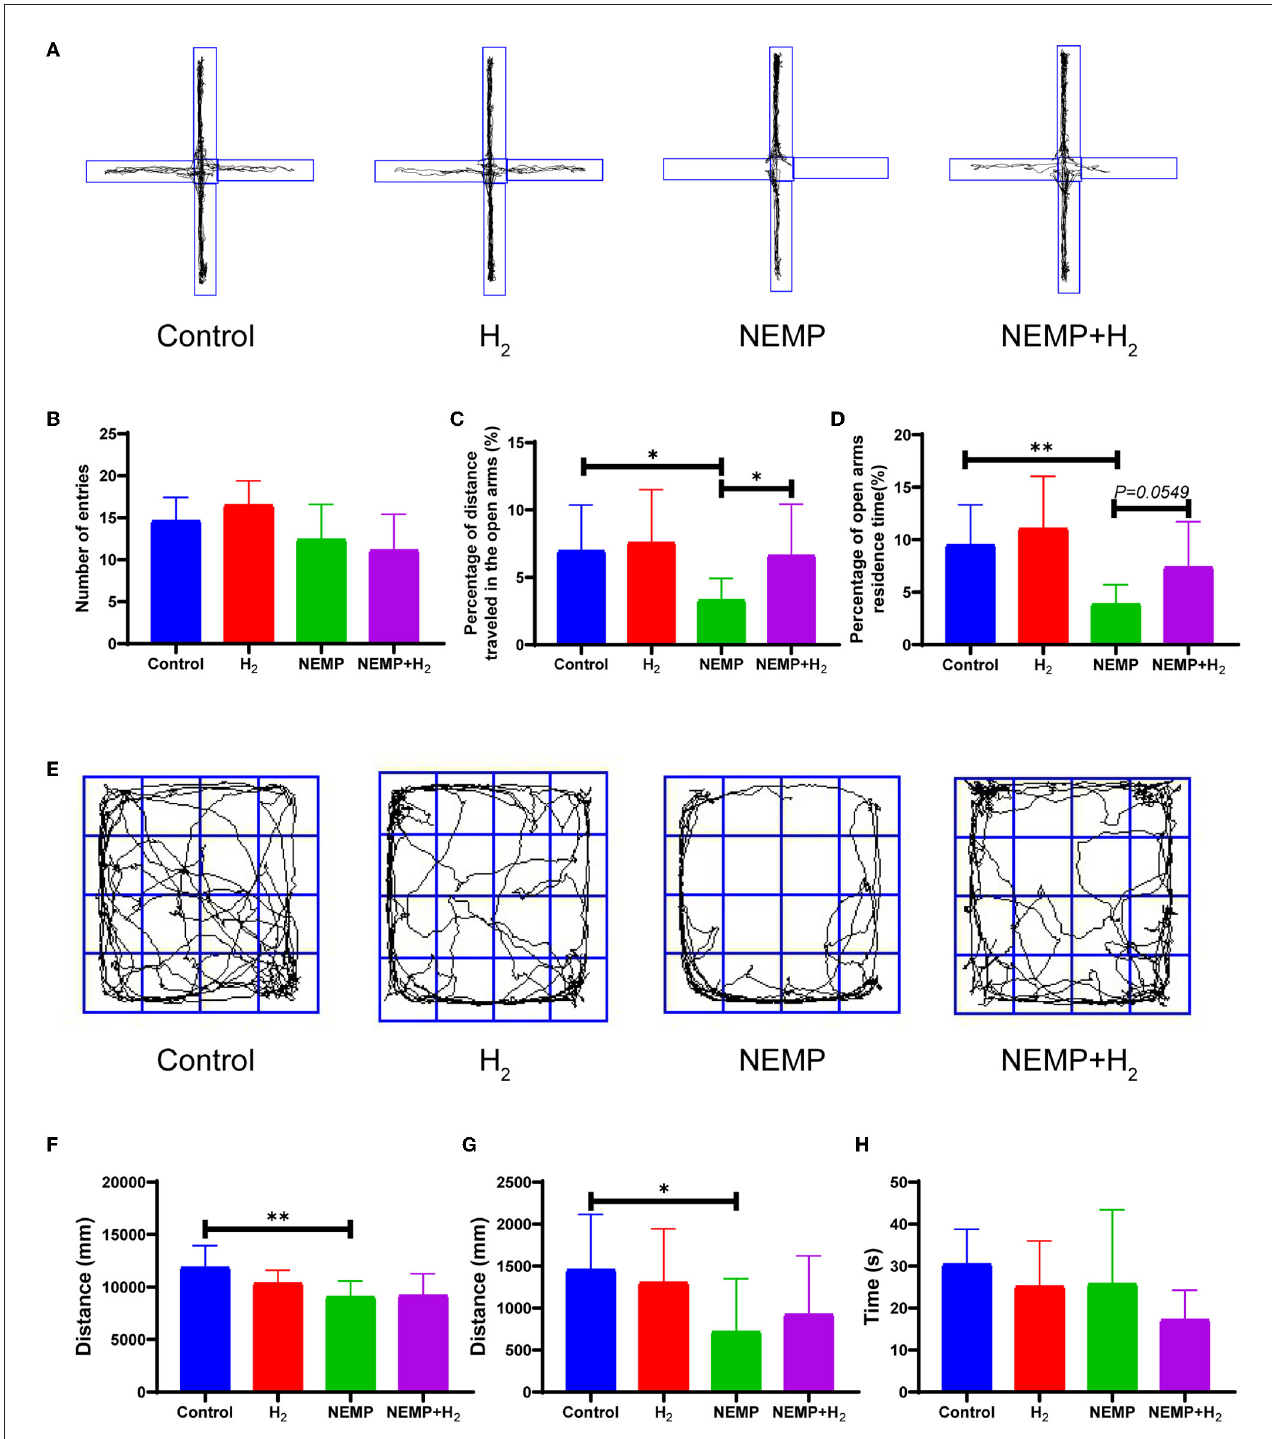
FIGURE3 Effects of EMP exposure and H 2 administration on anxiety-like behavior. (A) Representative movement track diagrams of rats in EPM. (B) Total number of entries into the arms in EPM. (C) Percentage of distance traveled in the open arms in EPM. (D) Percentage of open arms residence time in EPM. (E) Representative movement track pictures of rats in OFT. (F) Total distance traveled in OFT. (G) Distance traveled in the center area in OFT. (H) Time spent in the central area in OFT. N = 10. All data are presented as mean ± SD. * p < 0.05, ** p <